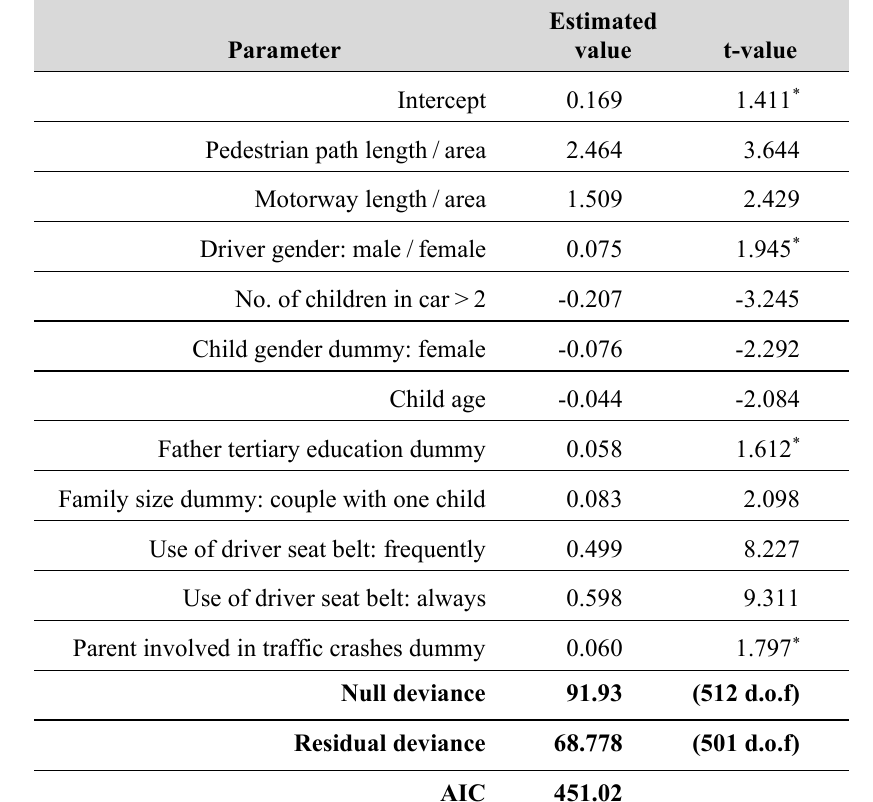
Table 1 Generalized linear model estimation